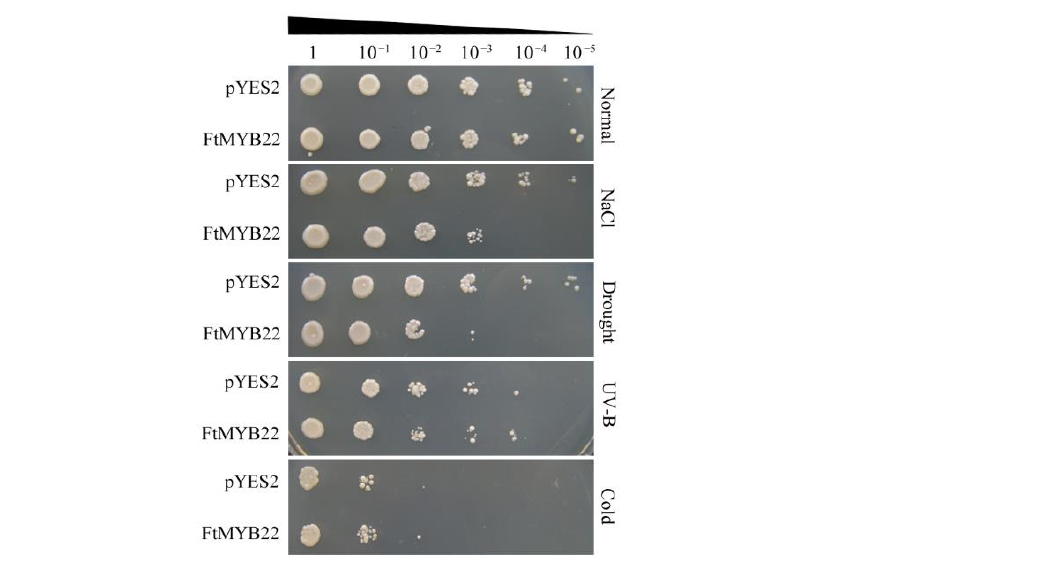
Figure 4. Growth phenotype of FtMYB22 transgenic yeast under stress conditions as indicated. The yeast cells containing recombinant plasmids were serially diluted by 10, 100, 1000, 10,000, and 100,000 folds, and then respectively cultured on SC/ − Ura medium. 30% ( w/v ) PEG6000 (for the water deficit) or 5 M NaCl (for the salt stress) was added to the cell fluid and cultured at 30 °C for 36 h. For the UV-B stress, the yeast cells were placed in 10 W UV-B (308 nm) LED for 36 h; the illumination distance from lamp to bacterial liquid was 30 cm, and the radiation intensity was 0.1 mW/cm 2 . Yeast cells were resuspended in SC-ura medium and cultured at − 20 °C for 24 h for the cold stress. For the normal control , the same amount of yeast cells was resuspended in 200 μL of sterilized water and cultured at 30 °C for 36 h.